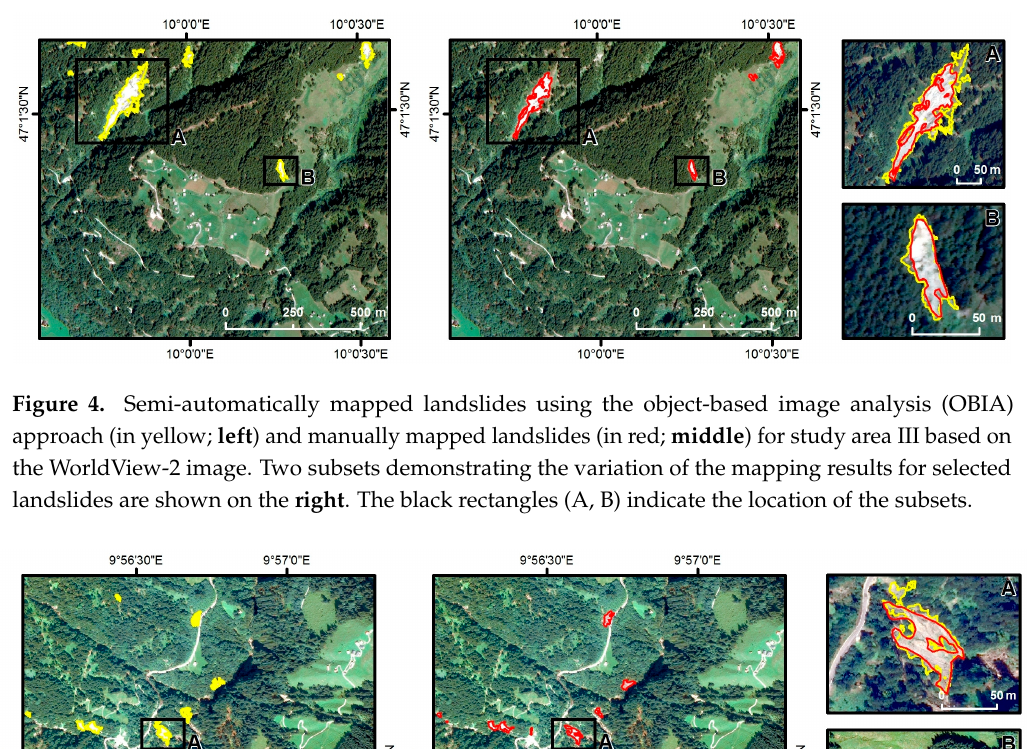
Figure 3. Semi-automatically mapped landslides using the object-based image analysis (OBIA) approach (in yellow; left ) and manually mapped landslides (in red; middle ) for study area II based on the SPOT-5 image. Two subsets demonstrating the variation of the mapping results for selected landslides are shown on the right . The black rectangles (A, B) indicate the location of the subsets.